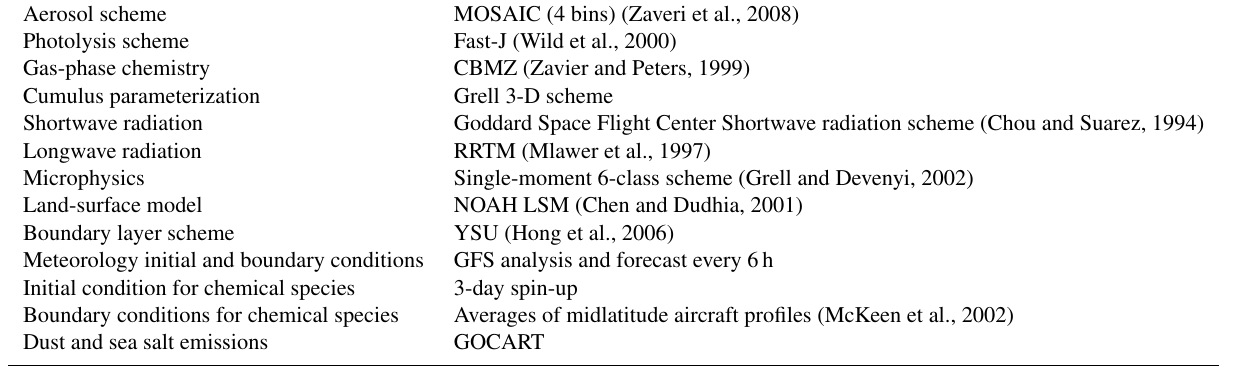
Table 1. WRF-Chem model configurations.